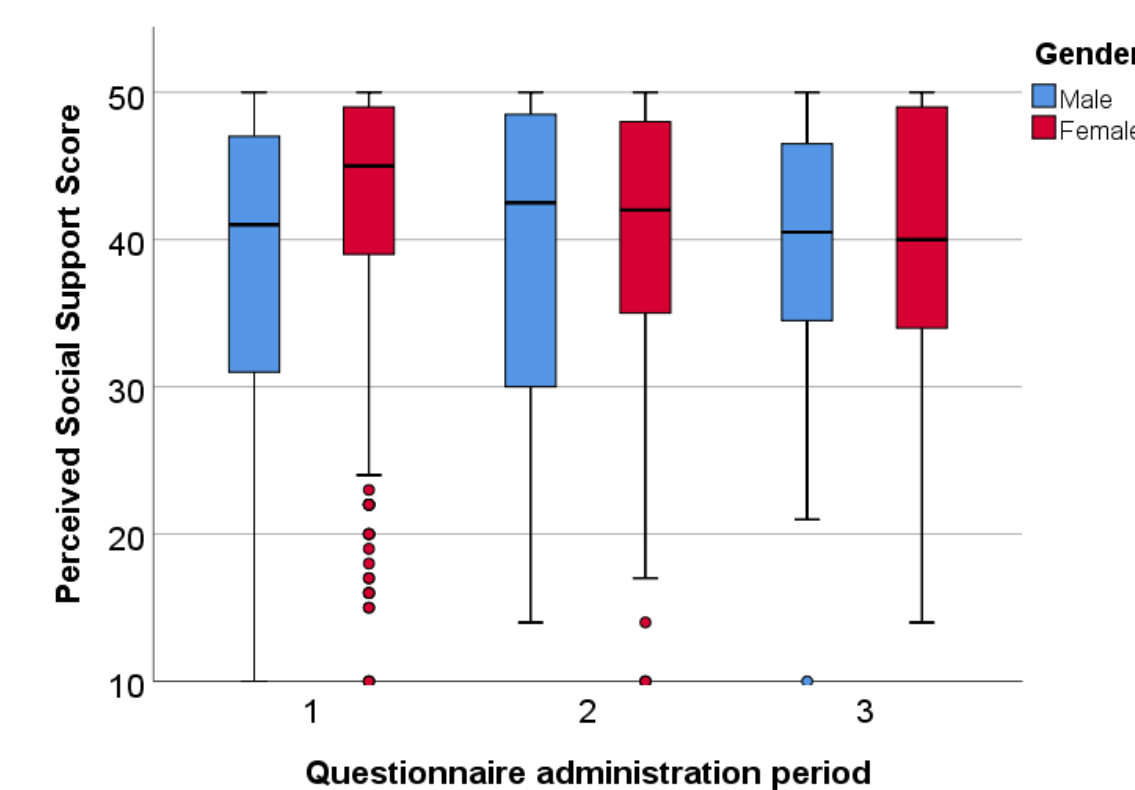
Figure 1. Gender differences in perceived social support among Hungarian students. Table 2. Gender differences in perceived social support subscales among Hungarian